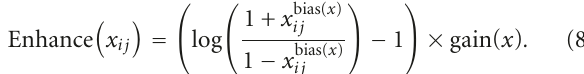
narrows a smaller range of input values to the display range. The gain function is used to help shape how fast the mid- range of objects in a soft region goes from 0 to 1. A higher gain value means a higher rate in change. The enhanced pixel